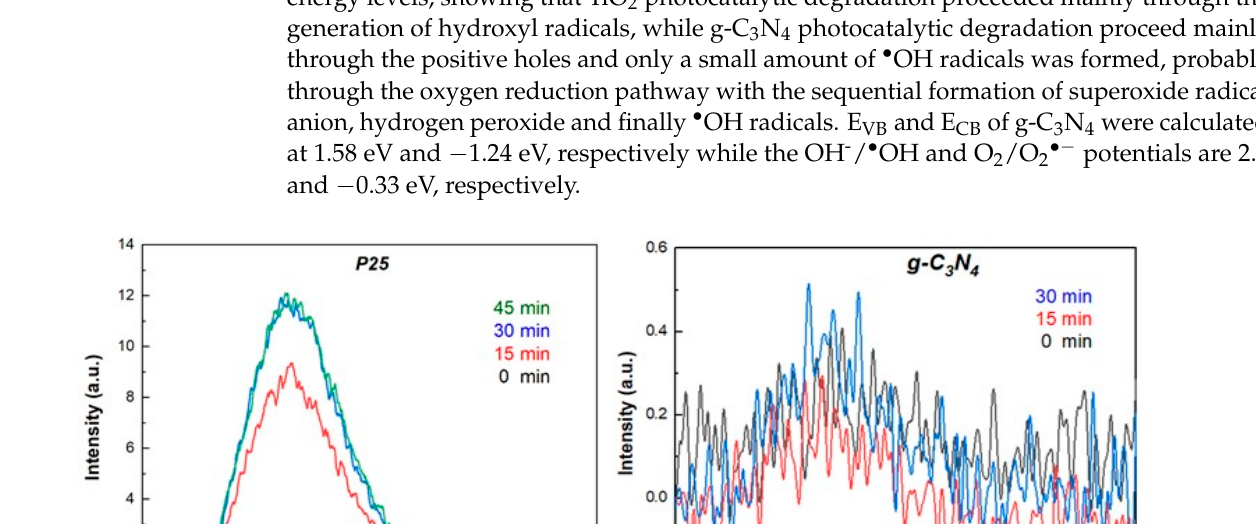
Table 1. UPLC-ESI-HR-MS data (pseudo-molecular ions (M + H) + or (M − H) − * /(M + Na) + ; chemical formula; mass error Δ (ppm); and ring-double\bond equivalents, RDB) for VLS and transformation products by g-C 3 N 4 photocatalytic oxidation.